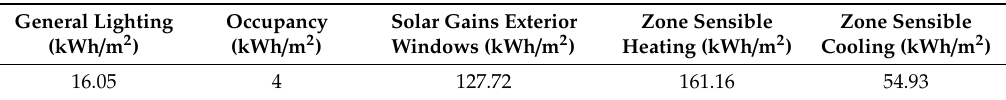
Table 4. Internal gains of the